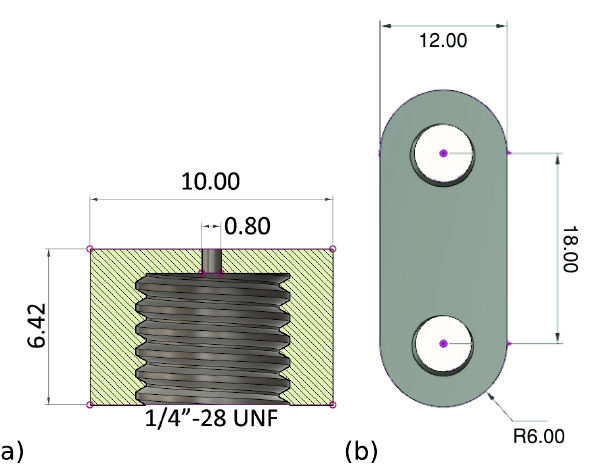
Figure 3. ( a ) Macroscopic connection part to liquid supply [13] ( b ) Macroscopic connection to stage [13] (dimensions in mm).